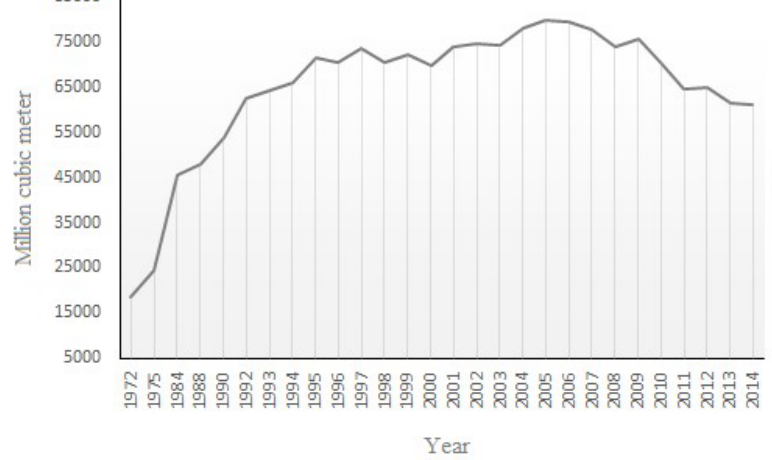
Figure 3. The annual amounts of extracted ground water in Iran. Source: Iranian Water Resource Management Company [18].